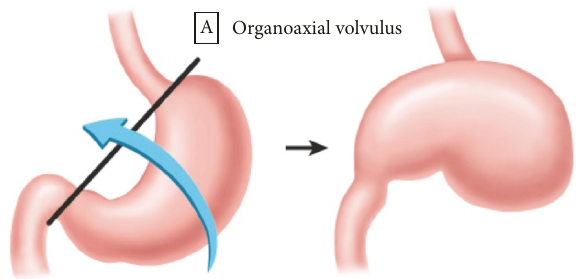
Figure 1: Organoaxial gastric volvulus. Rotation of the stomach along its long axis through a line that connects the gastroesophageal junction and the pylorus. The antrum rotates anterosuperiorly and the fundus rotates posteroinferiorly. The greater curvature of the stomachcomestorestsuperiortothelessercurvatureofthestomach in an inverted position.